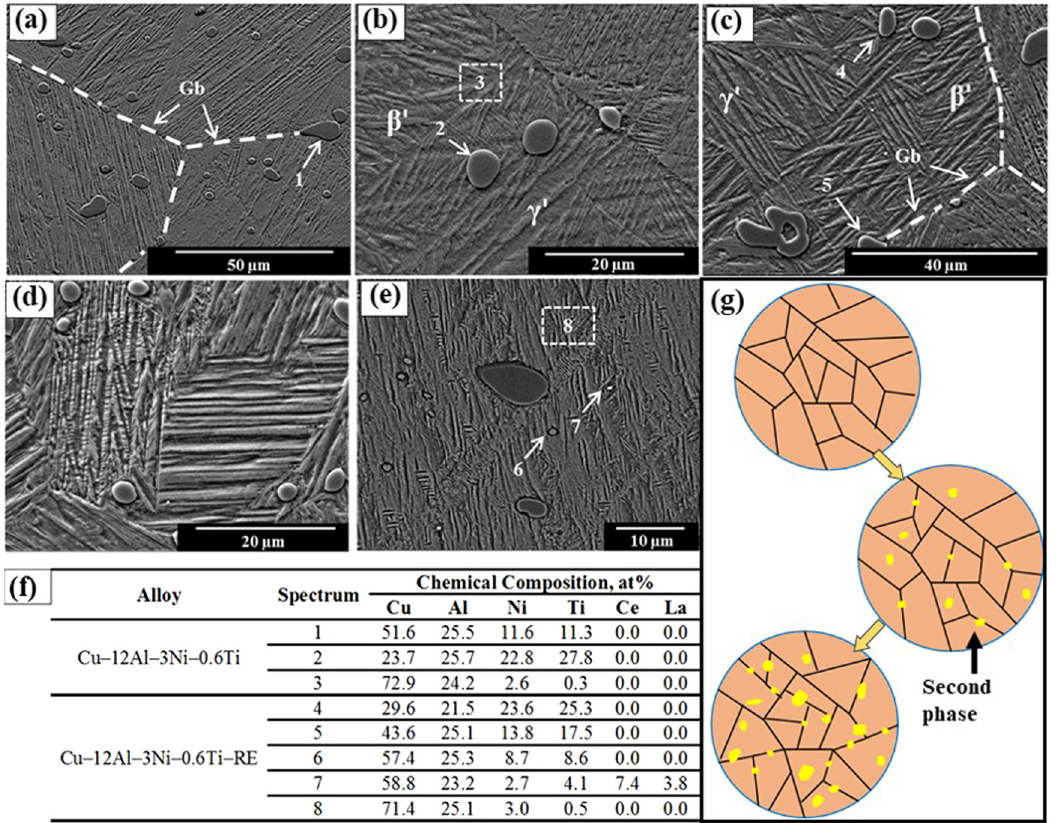
Figure 5: SEM micrographs of the alloys: ( a and b ) Cu – 12Al – 3Ni – 0.6Ti alloy, ( c – e ) Cu – 12Al – 3Ni - 0.6Ti – RE alloy, ( f ) table of element distribution in numbered areas in ( b and e ) , and ( g ) simple schematic diagram of second phase precipitation [ 95 ]